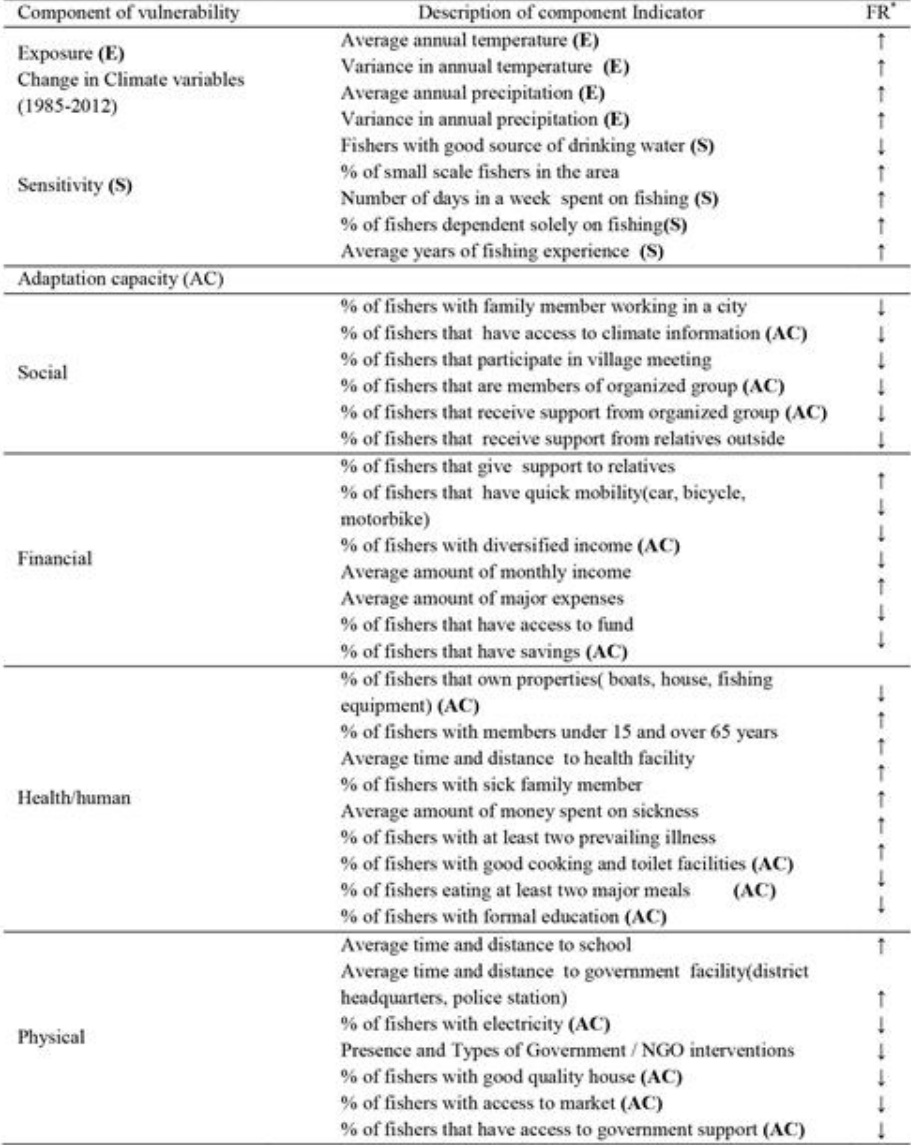
Table 1: Component of vulnerability and description of component